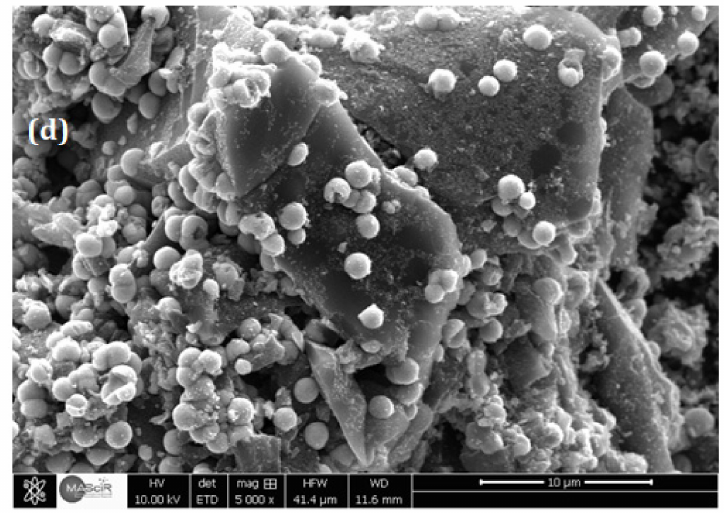
Figure 3. SEM image of AC and AC/TiO 2 ball with different magnifications: ( a ) AC, ( b ) AC/TiO 2 -b 38%, ( c ) AC-TiO 2 -b 53%, and ( d ) AC/TiO 2 -b 63%.